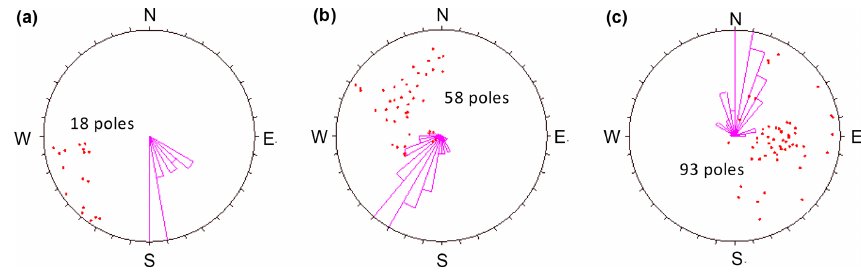
Figure 3. Poles and strike rose diagrams of the fracture sets. (a)–(c) Fracture sets 1, 2, and 3.